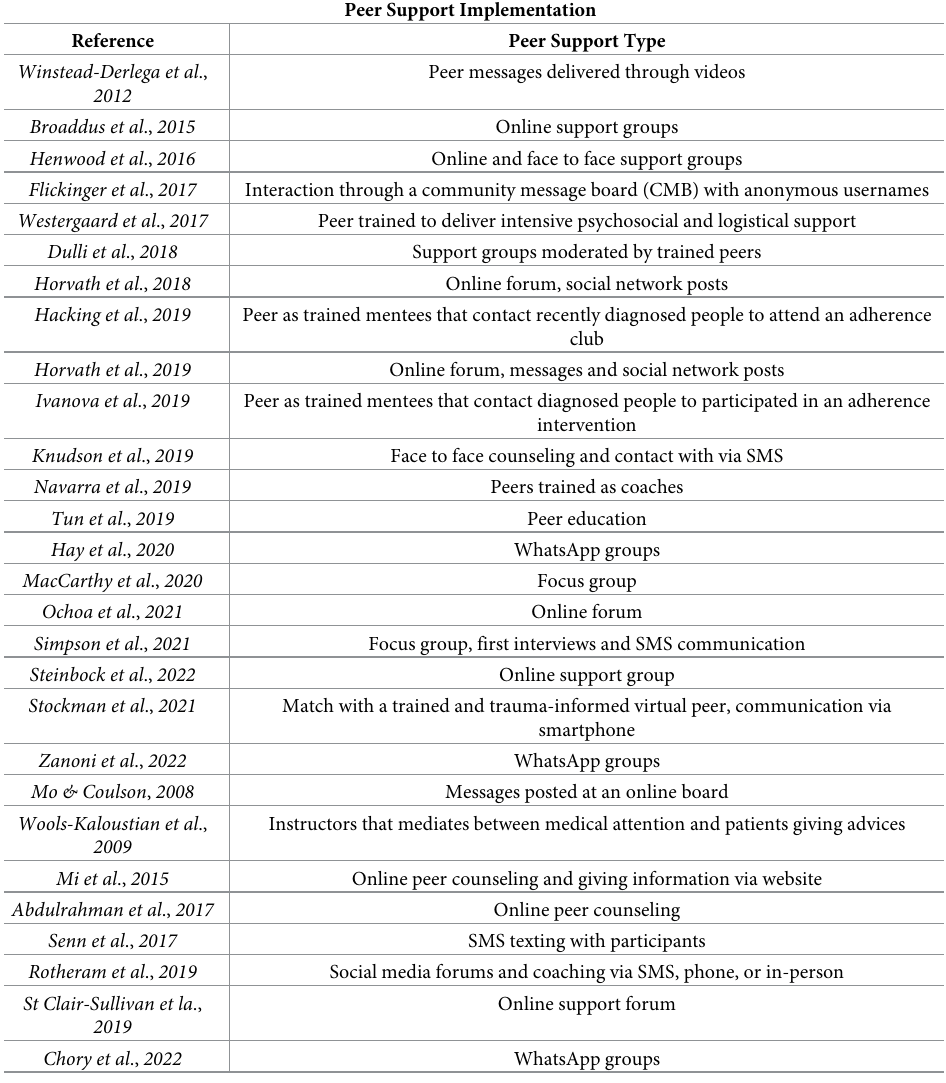
Table 4. Description of how the peer support was